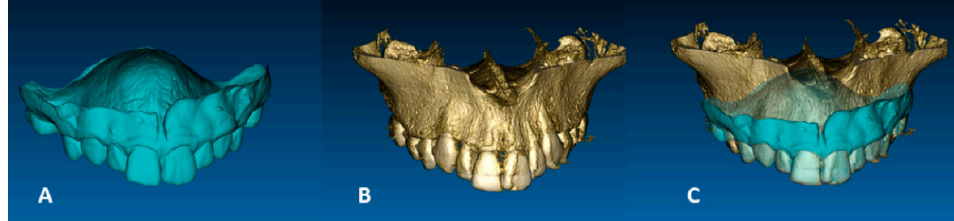
Figure 3. Alignment between virtual model of maxillary dental arch ( A ) and virtual model of the maxilla cone beam computed tomography (CBCT) ( B ) to create the integrated model ( C